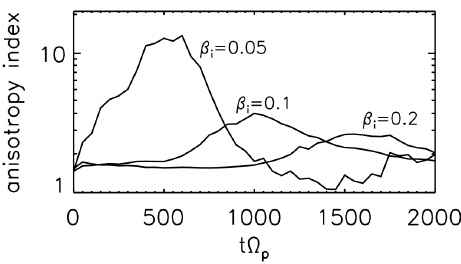
Figure 3. Anisotropy evolution for the data obtained by nu- merical simulation in a broad range of wavenumbers (0 . 3 < kV A < 6) at the values of ion beta (from top to bottom) β i = (cid:127) p { 0 . 05 , 0 . 1 , 0 . 2 , 0 . 5 , 1 , 2 } .